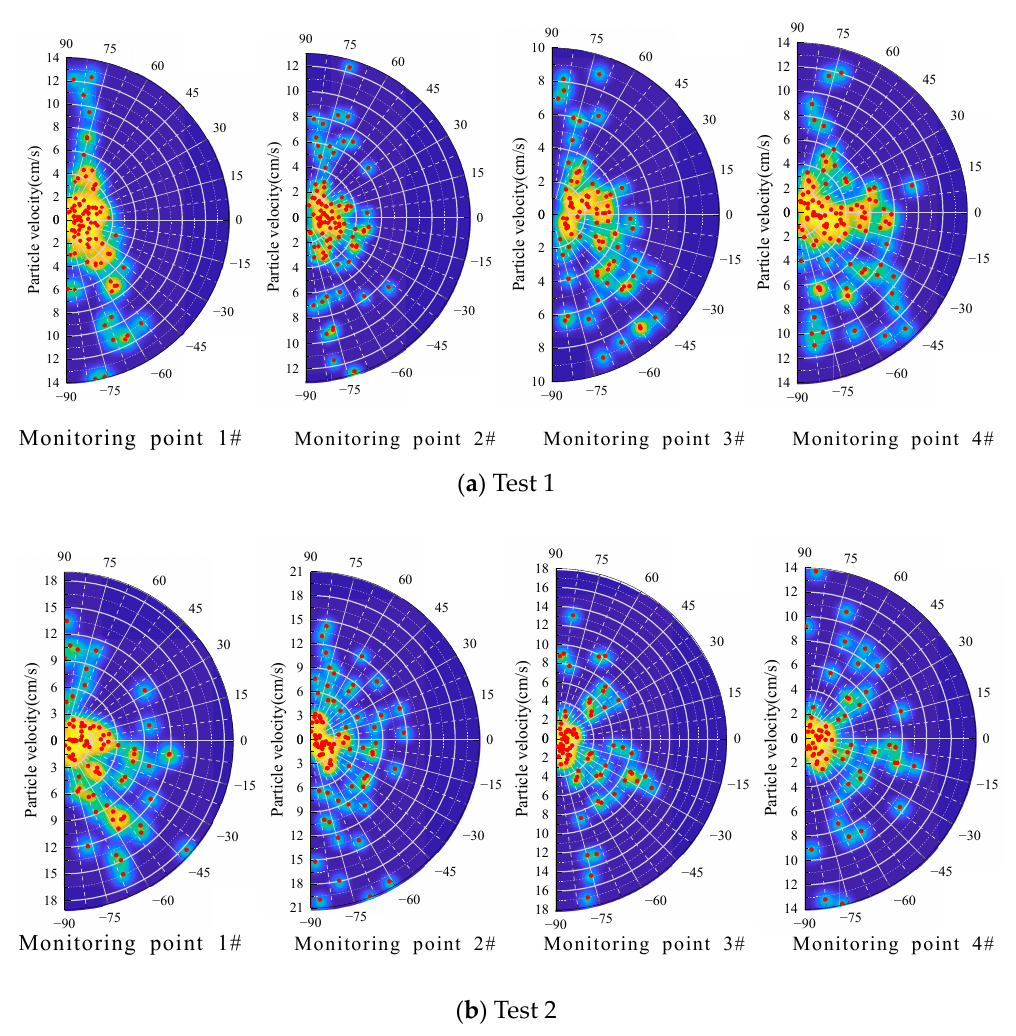
Figure 10. The ν xyz − α distribution hotspot diagram of particle velocity extremum. The closer α is to the ±90° axis, the more dominant v z becomes in the 3 directions. Hotspot maps are drawn on a semicircle plane of polar coordinates based on the dispersion distribution of particle velocity extremum, and then the distribution characteristics of particle velocity extremum are analyzed. The thermal diagram shows that the scatter points near the origin are randomly distributed on the angle interval, while the scatter points near the edge of the arc are more in the large angle interval, resulting in the overall distribution of the image strip.